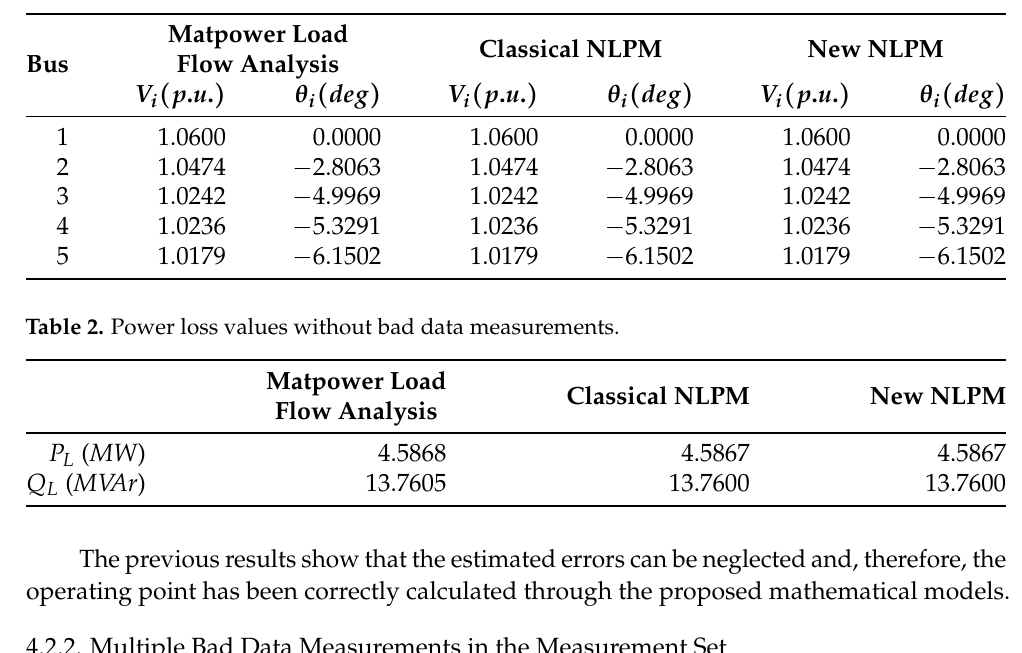
Table 1. Comparison between real and estimated operation point.